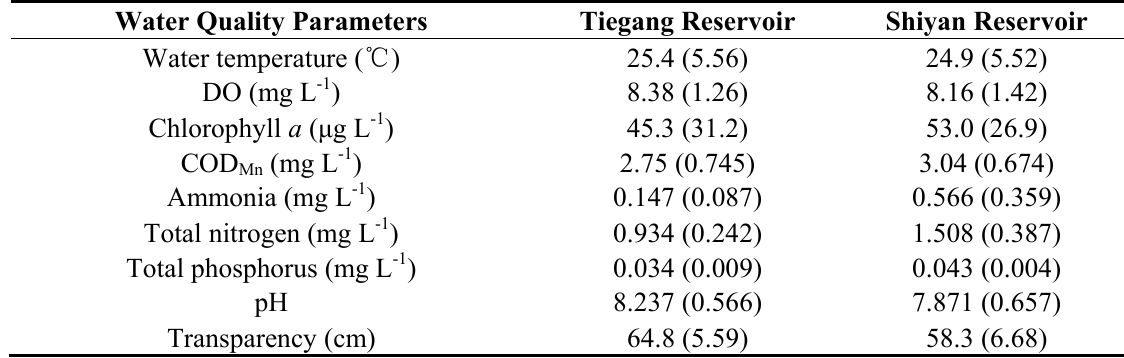
Table 1. Mean value of water quality parameters in Tiegang and Shiyan Reservoirs in 2007 (standard deviations in parentheses).